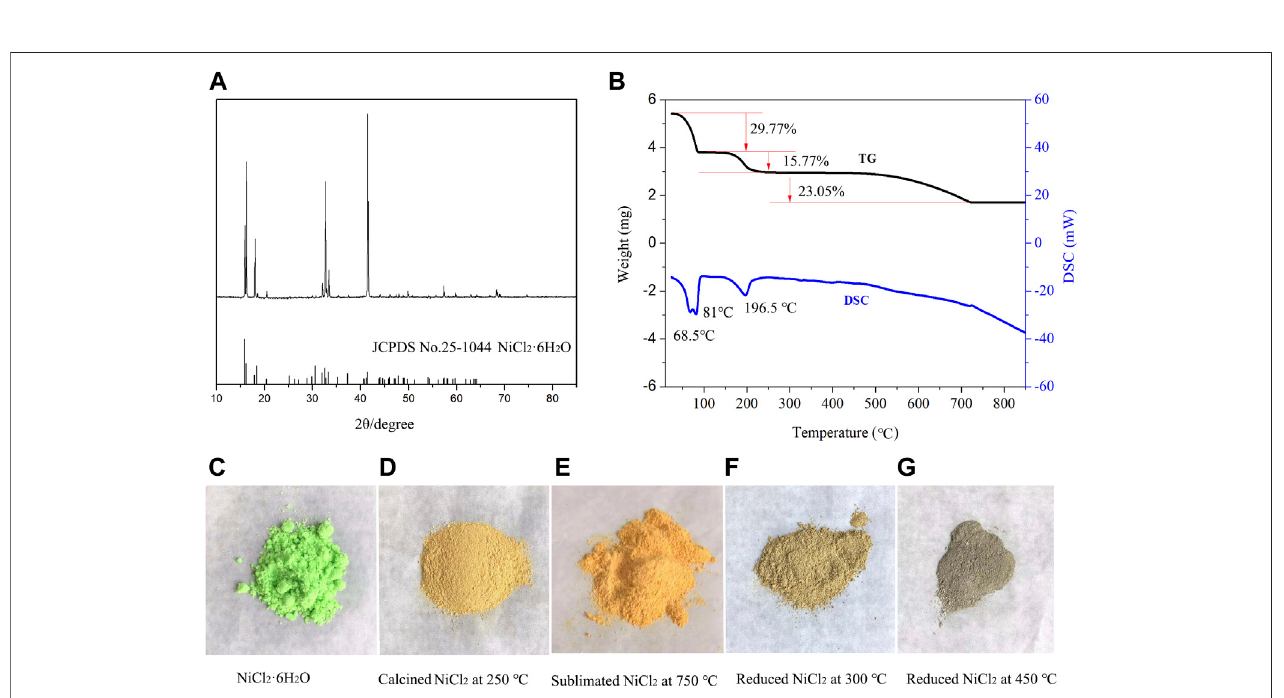
FIGURE2|(A) XRDpatternsofNiCl 2 .6H 2 O, (B) thermalanalysiscurves,and (C) picturesofNiCl 2 .6H 2 O, (D) NiCl 2 calcinedat250 ° C, (E) NiCl 2 sublimatedat750 ° C, (F)